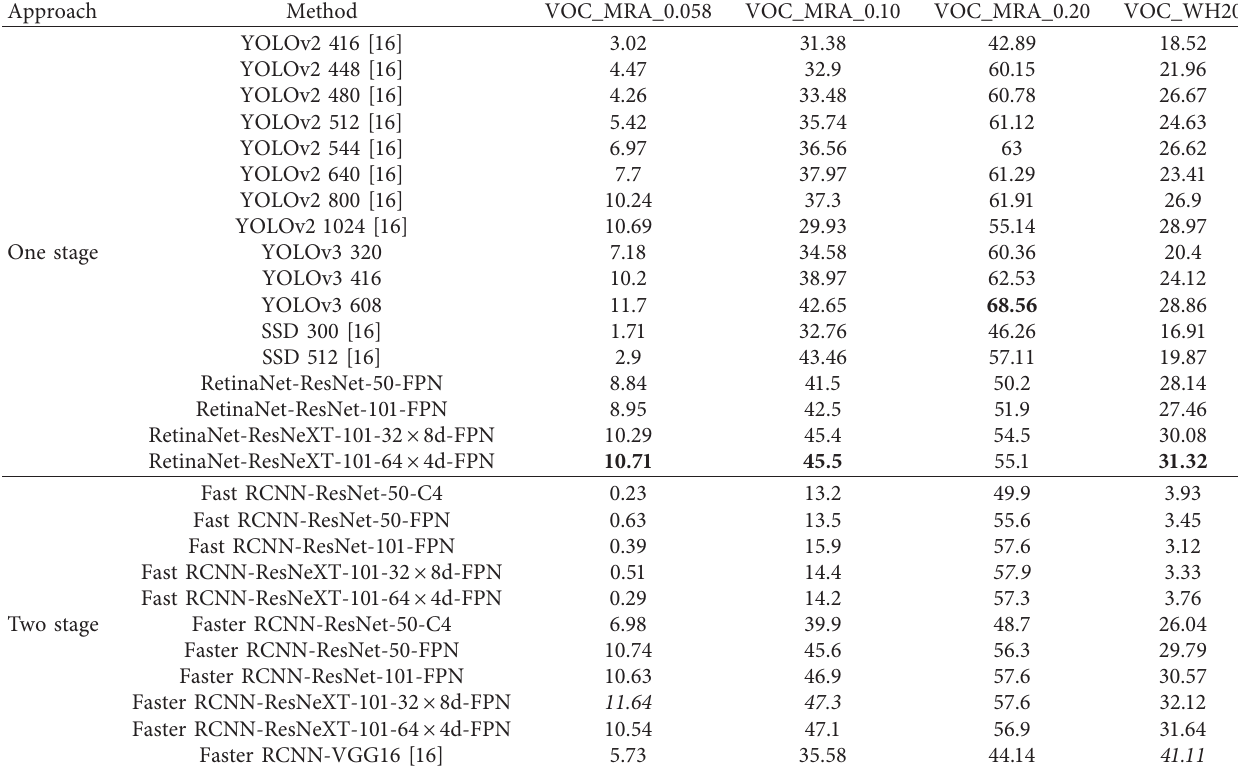
Table 4: The comparative results on subsets of PASCAL VOC